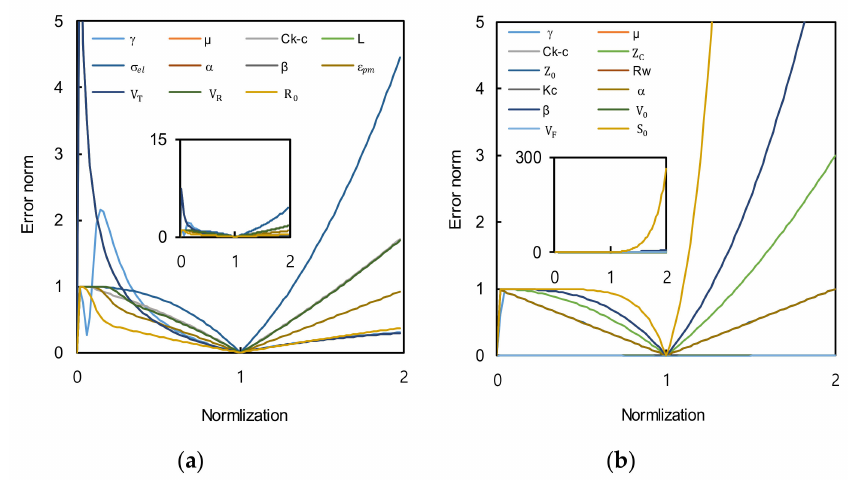
Figure12. Thesensitivityofeveryinputparameterintheoreticalmethodsbasedon: ( a )Dalton et al. [15]; ( b ) Nadler et al. [16]. Table 3. The reference values for performing the sensitivity analysis. Theoretically Derived Equation (11) Theoretically Derived Equation (12) Input Value > Reference